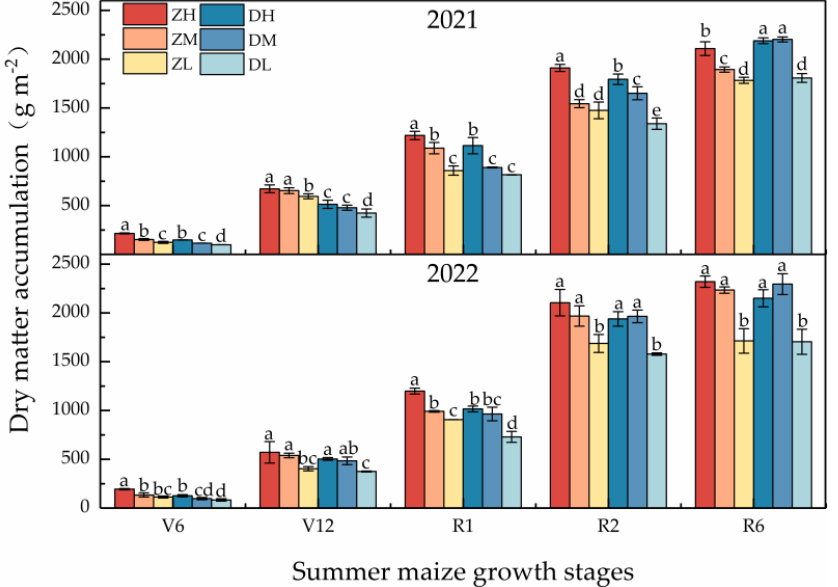
Figure 6. Effects of planting densities and genotypes on dry-matter accumulation at V6 (the sixth − leaf stage), V12 (the twelfth − leaf stage), R1 (silking stage), R2 (filling stage), and R6 (mature stage) in 2021 and 2022 summer maize growing seasons. Z represents Zhengdan 958, D represents Denghai 605; H represents high density, M represents middle density, and L represents low density. Vertical bars represent standard errors. Bars labeled at the top of the column with different letters are significantly ( p < 0.05) different among treatments using LSD post hoc test.